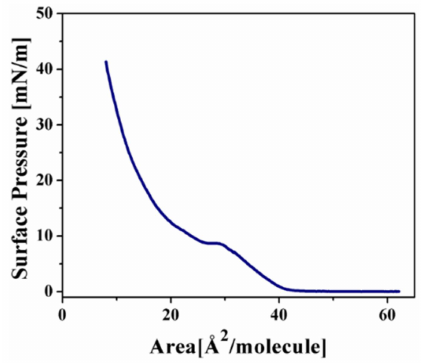
Figure 2. Surface pressure vs. area isotherm of ferrocenyl aminocarbene complex 2a , M = Cr.